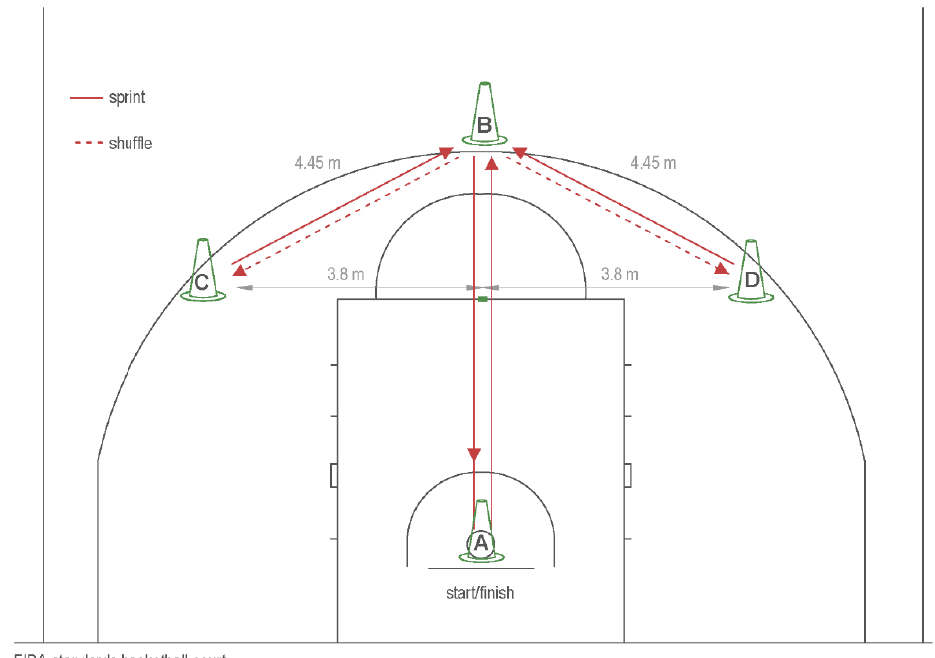
Figure 6. The trajectory of the Lane Arrow Closeout Test. Adapted and edited from the article by Stojanović et al. [18] from which the full description of the test can be found.